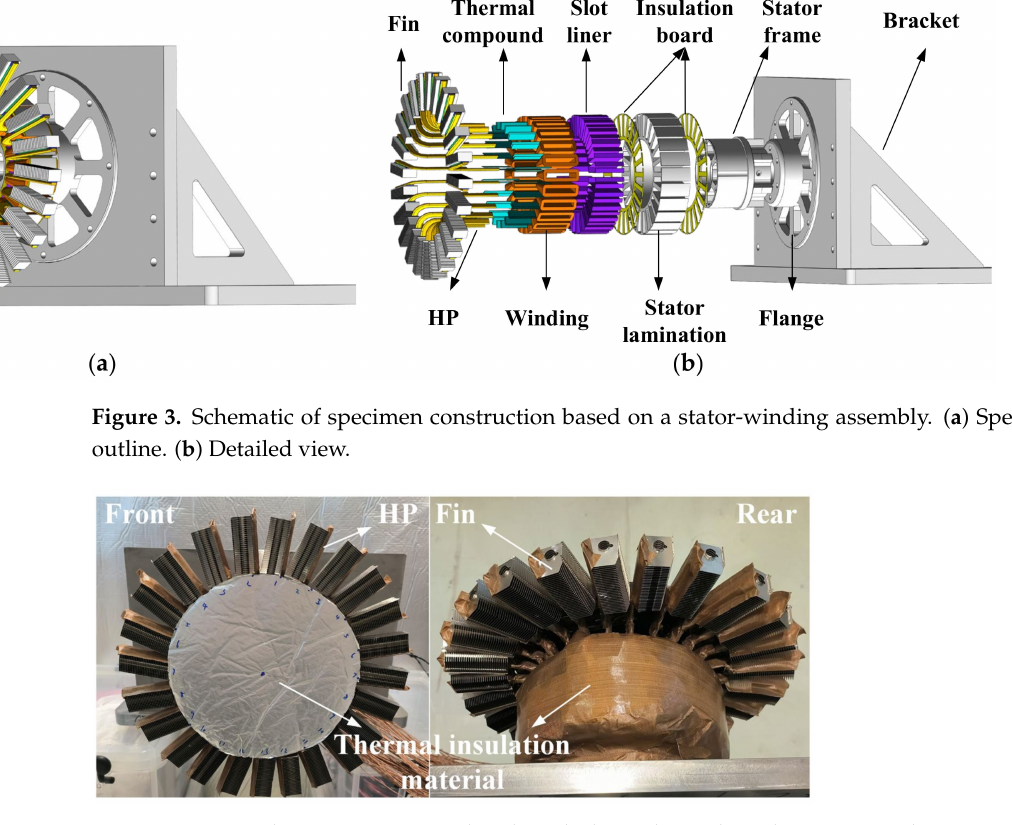
Figure 4. Prepared specimen wrapped with multi-layer thermal insulation material.